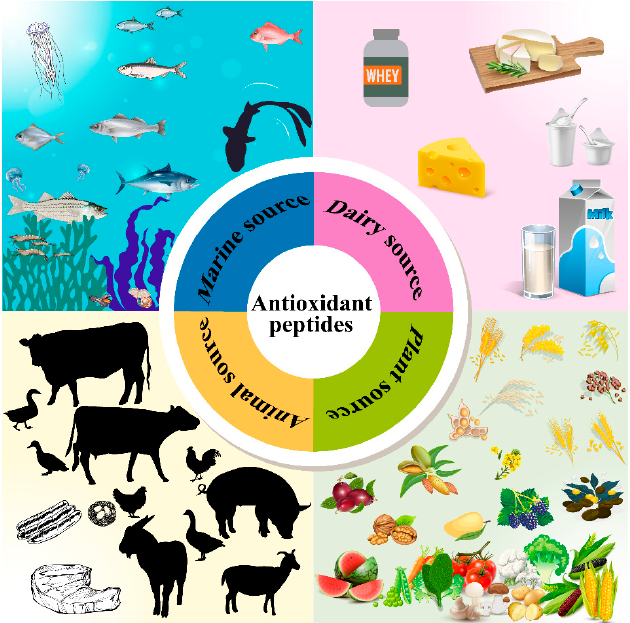
Figure 1. The main food-based sources of antioxidant active